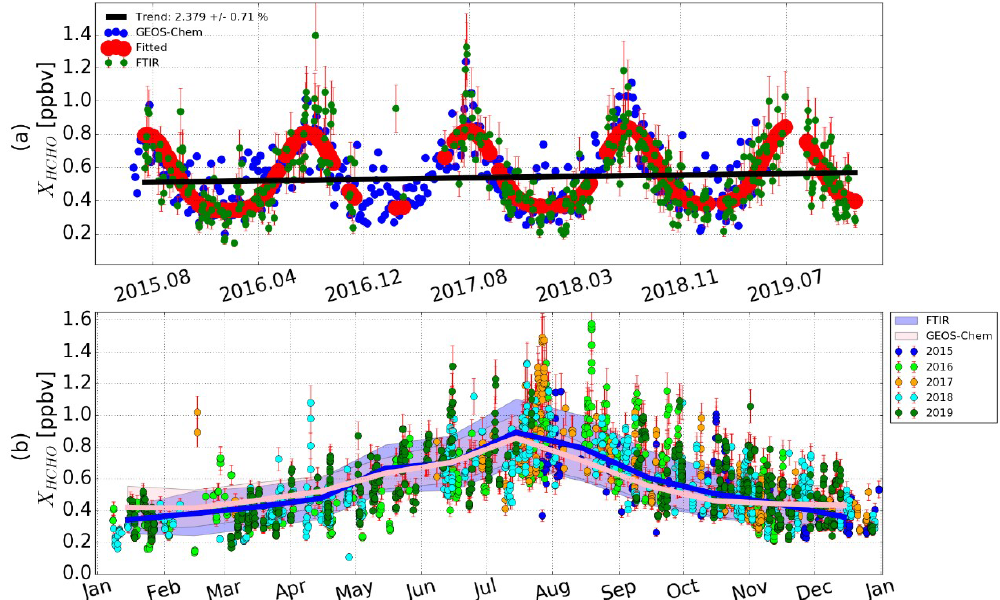
Figure 4. Daily mean time series of X HCHO comparison between FTIR observation and GEOS-Chem model BASE simulation from 2015 to 2019 over Hefei, China (a) . The seasonality and interannual change rate are represented by red dots and black line, respectively, which are fitted by using a bootstrap resampling model with a third Fourier series plus a linear function. (b) Seasonal variations of X HCHO by FTIR and GEOS-Chem simulation. Bold curves and the shadows are monthly mean values and the 1 σ standard variations, respectively. Vertical error bars represent retrieval